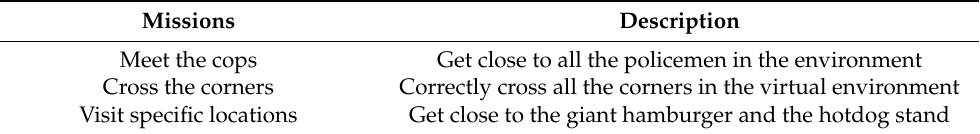
Table 6. Missions implemented in the “Street Simulator” game.